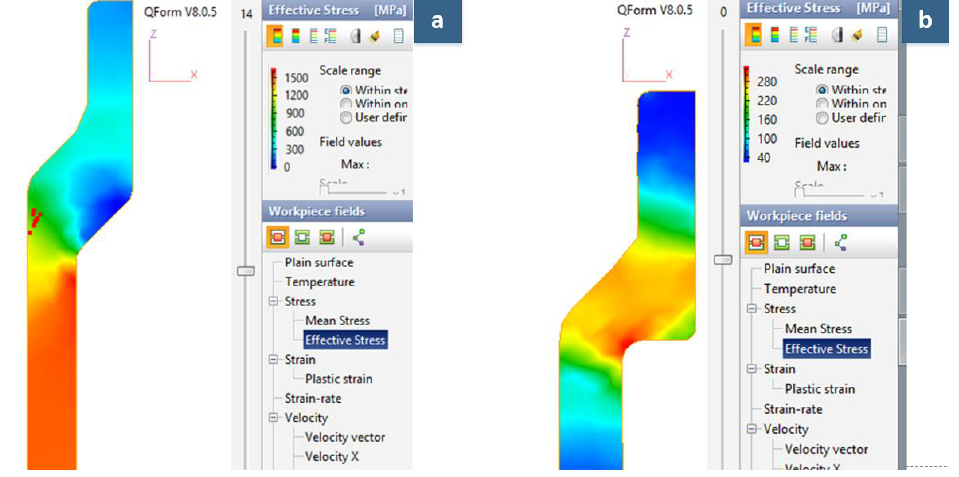
Figure 7. Equivalent stress distributions (von Mises stress) with ( a ) one-step stamping and ( b ) two-step stamping.